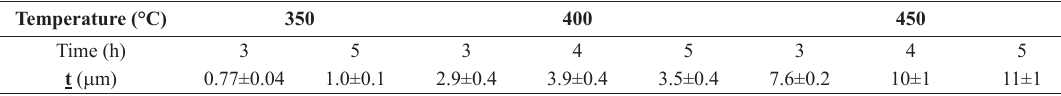
Table 1. Thickness ( t ) of the samples’ nitrided layers 17